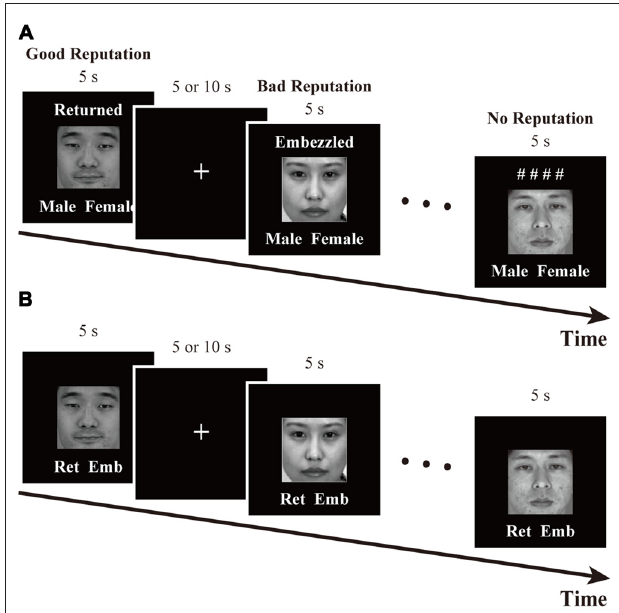
FIGURE 2 | Time courses of (A) the reputation-learning task and (B) the action-inference task . Labels were written in Japanese during the experiments: Returned